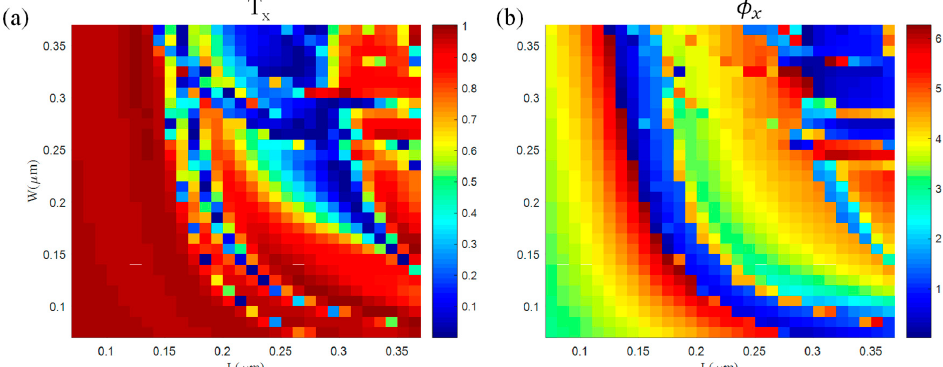
Figure 3. ( a ) Transmittance and ( b ) phase delay for x-linearly polarized light incidence with differ- ent lengths L and widths W.